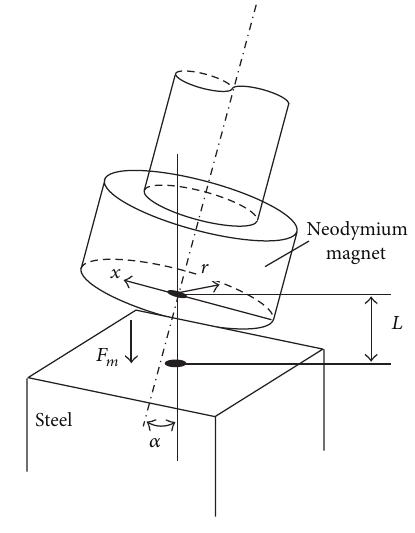
Figure 6: Magnetic force for tilted spoke.